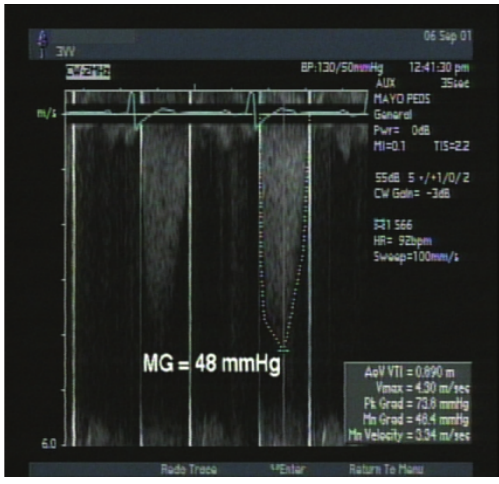
Figure 1: Continuous-wave Doppler recording from the pre- operative transthoracic echocardiogram. This Doppler recording from the apical position demonstrates a mean gradient (MG) of 48mmHg across the aortic valve prosthesis.